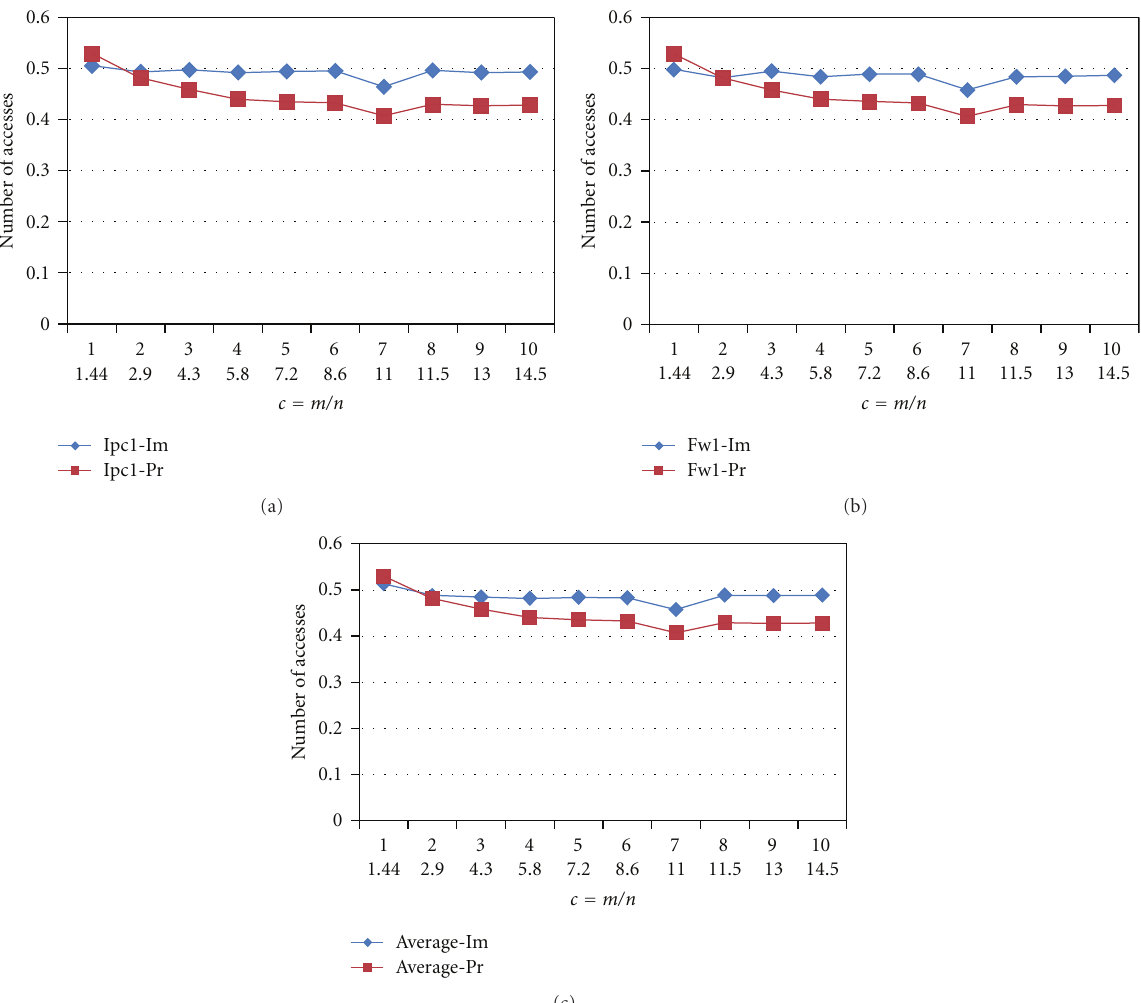
software implementation and mathematical analysis